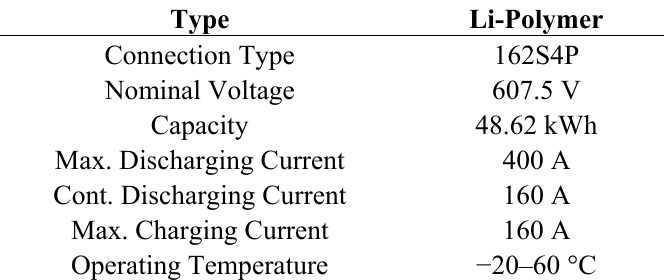
Table 3. Specification of battery pack.